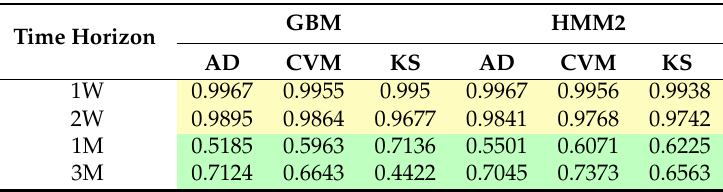
Table 4. Backtesting results for MXN/EUR, with a 3-year calibration window, quarterly re-calibration, and a 10-year backtesting